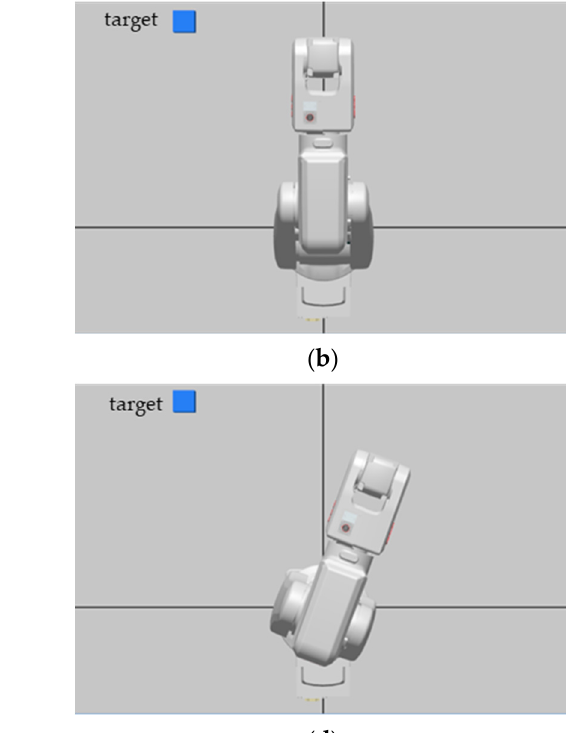
8 of 14 Figure 6. 6-degree of freedom industrial robot arm.